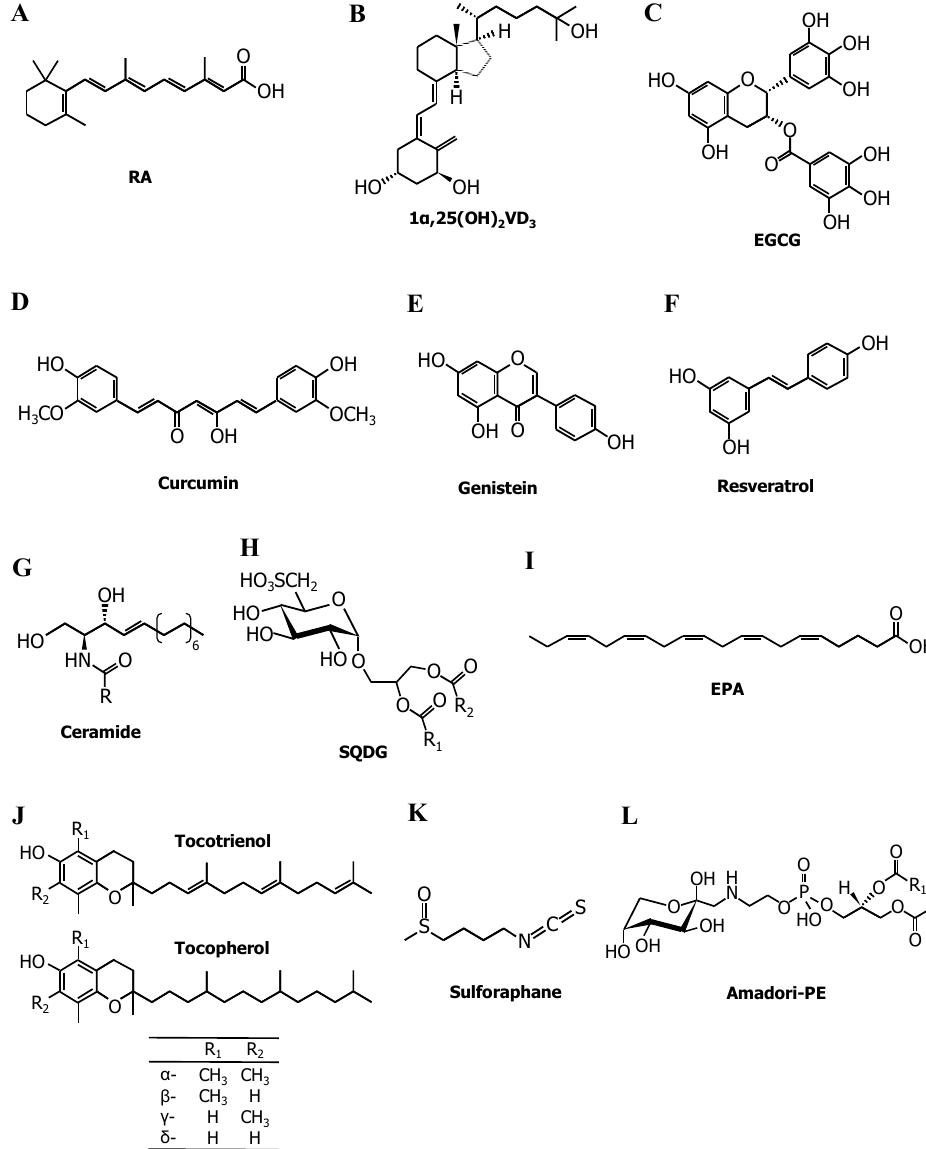
Figure 3. Chemical structures of telomerase modulators. ( A ) All- trans retinoic acid (RA). ( B ) 1 α ,25-Dihydroxyvitamin D 3 (1 α ,25(OH) 2 VD 3 ). ( C ) ( − )-Epigallocatechin-3-gallate (EGCG). ( D ) Curcumin. ( E ) Genistein. ( F ) Resveratrol. ( G ) Ceramide. R, acyl chain. ( H ) Sulfoquinovosyldiacylglycerol (SQDG). R 1 and R 2 indicate acyl chains. ( I ) Eicosapentaenoic acid (EPA). ( J ) Tocotrienol (T3) and tocopherol (Toc). ( K ) Sulforaphane. ( L ) Phosphatidylethanolamine-linked Amadori product (Amadori-PE). R 1 and R 2 indicate acyl chains.